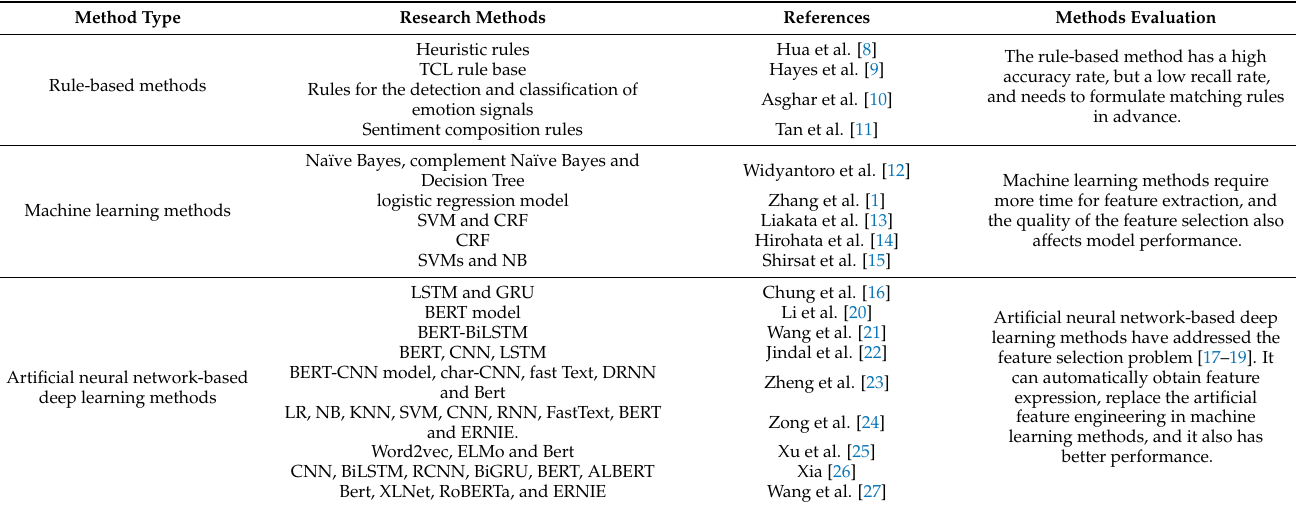
Table 1. Research status of text classification